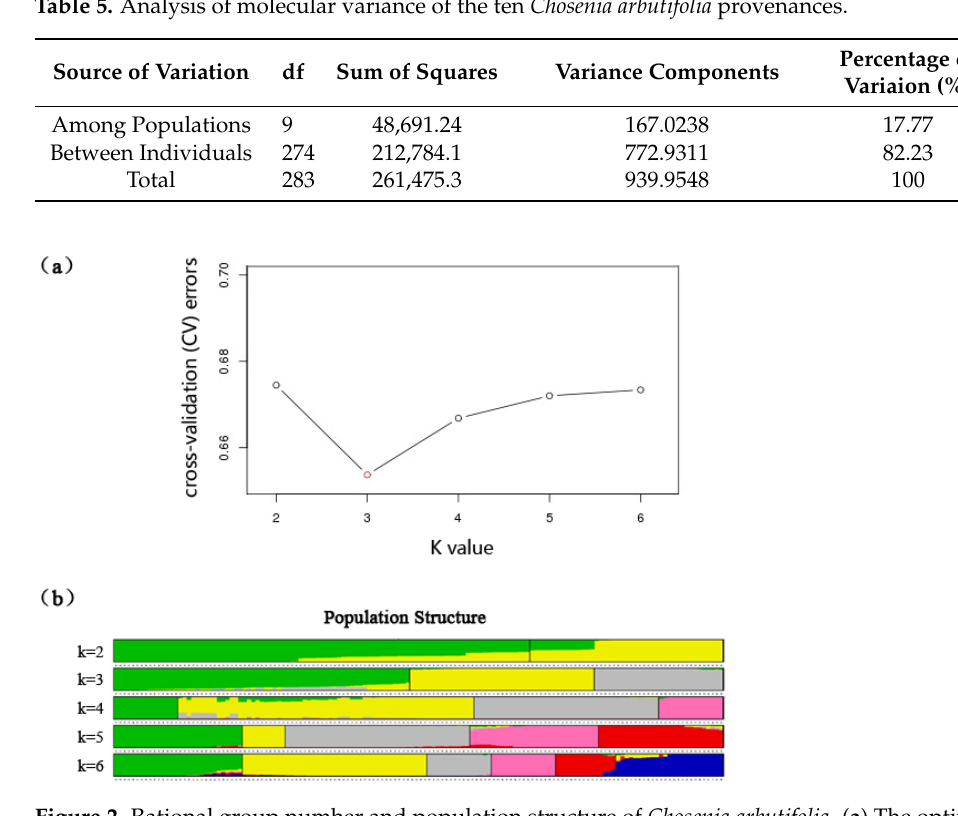
Table 5. Analysis of molecular variance of the ten Chosenia arbutifolia provenances .